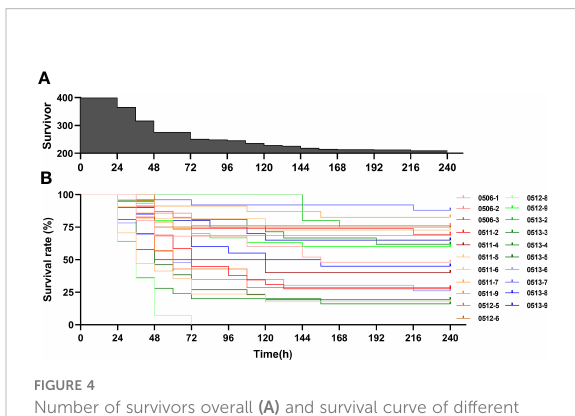
FIGURE 4 Number of survivors overall (A) and survival curve of different families (B) of Crassostrea angulata after heat challenge (44 °C, 1 h).